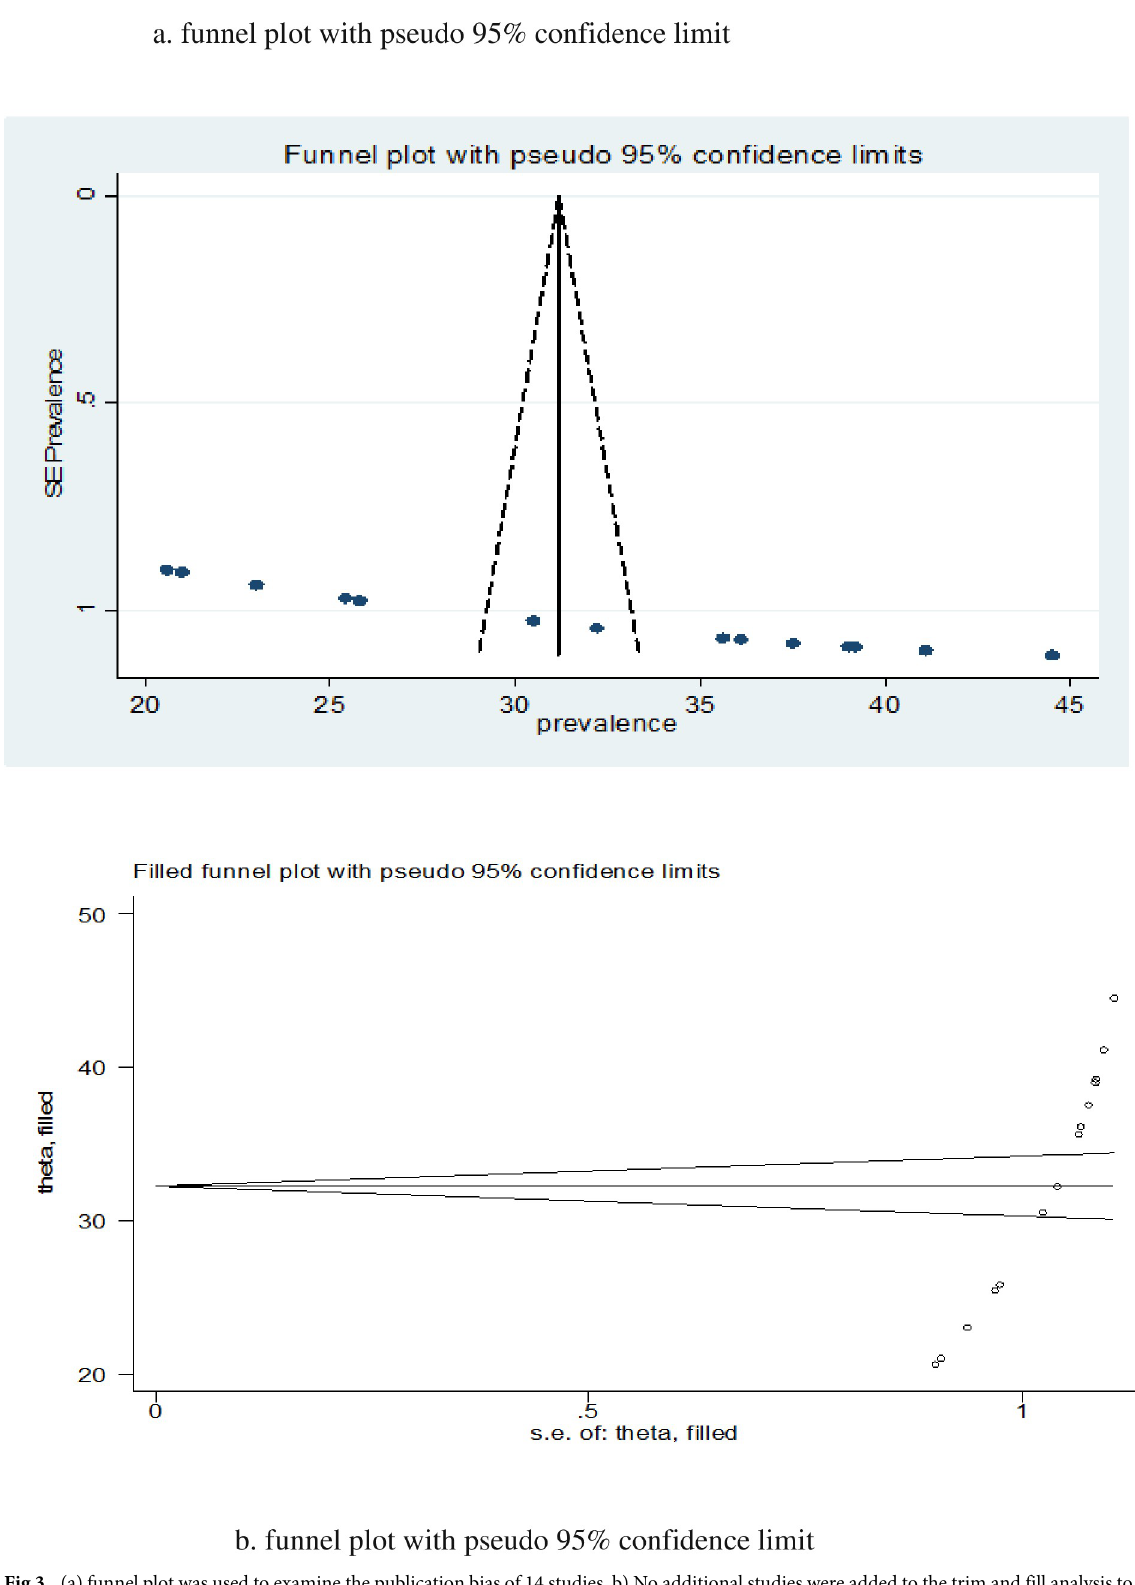
Fig 3. (a) funnel plot was used to examine the publication bias of 14 studies. b) No additional studies were added to the trim and fill analysis to correct publication bias. https://doi.org/10.1371/journal.pone.0275836.g003 PLOS ONE | https://doi.org/10.1371/journal.pone.0275836 December22,